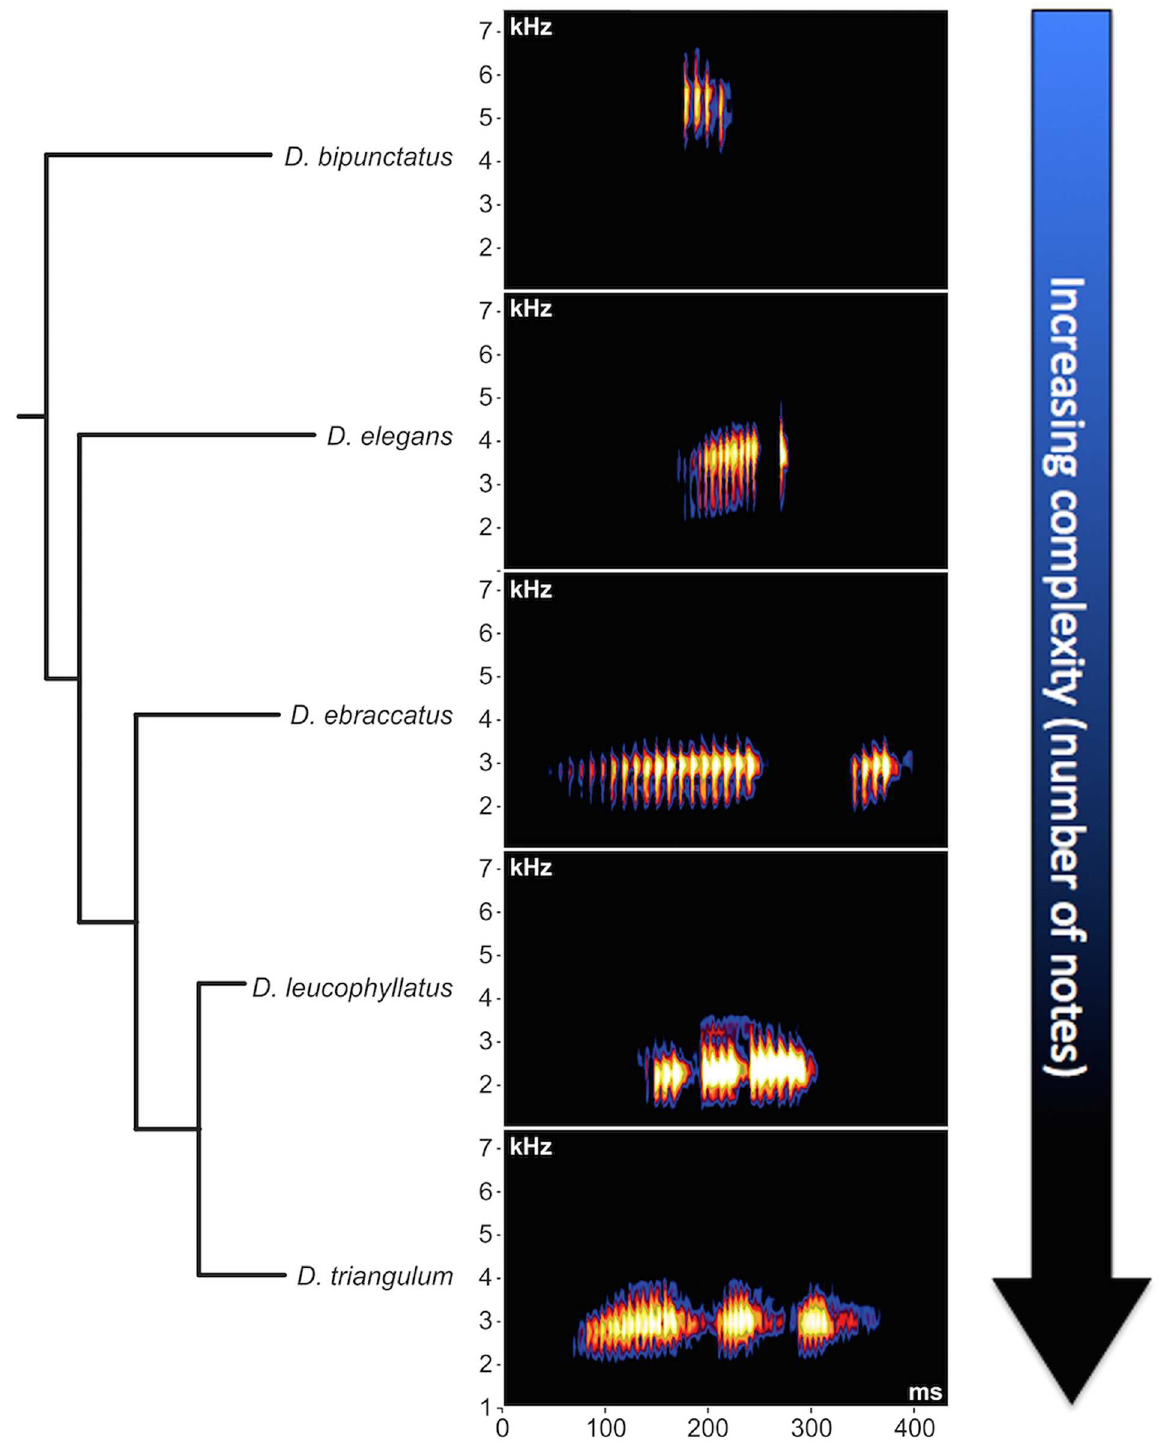
Fig 4. Phylogenetic representation of the spectrograms of five treefrog species. The phylogenetic topologyof these species is based on [29], and the figure is arrangedin a manner that highlightsincreasing advertisement call complexity (in terms of number of